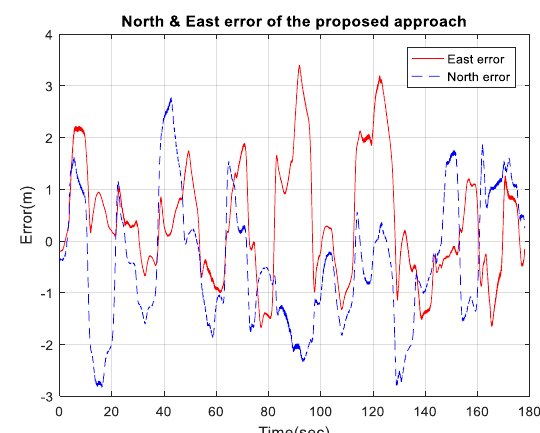
Figure 12. RMSE error trend of the proposed approach (camera and UWB) integrated with INS for a complete 180 seconds of GNSS signal